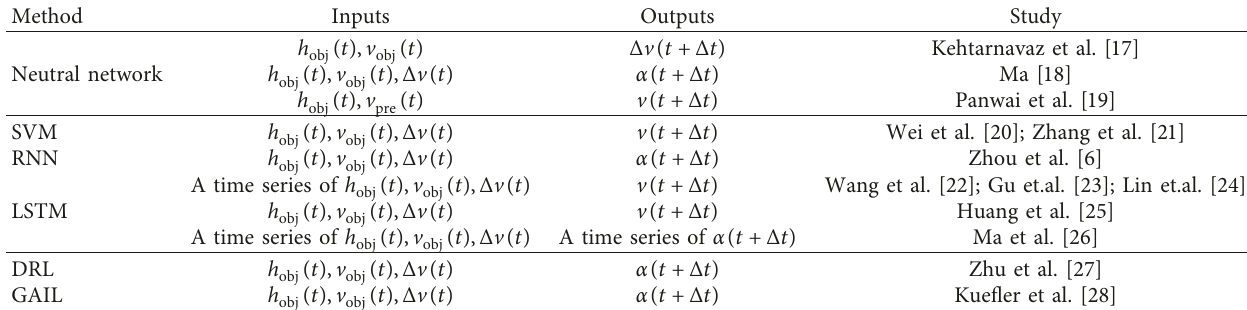
Table 1: The review of the data-driven